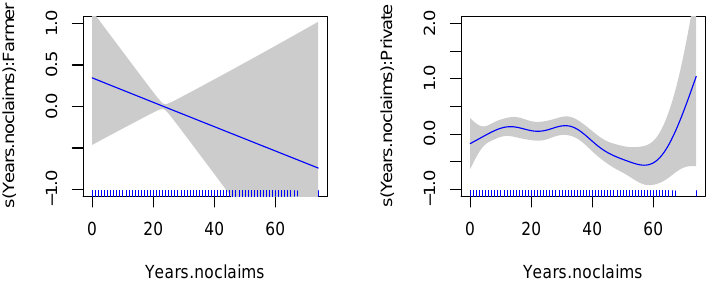
Figure 15. The plots of fitted spline functions for Years of no Claims, separated by Car Use. Table 6. Statistical test results and summary statistics for the GAM modelling of claim probability, with and without designed rating territories. Note that the test is based on Deviance, which is a goodness-of-fit statistic for the model, calculated based on the log likelihood-ratio; Pr (>F) is the p -value of the test. “Resid. Df” means Residual Degree of freedom; “Resid. Dev” means Residual Standard Deviation; “Df” means Degree of freedom.